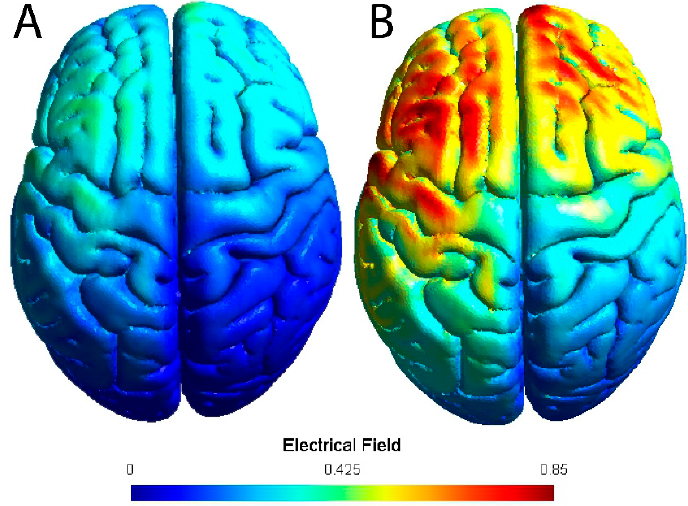
Figure 1. Model of the electrical field of the transcranial direct current stimulation montage used. The anode was placed over C3 and the cathode over the contralateral supraorbital area. ( A ) Electrical field using a standard 2 mA intensity. ( B ) Electrical field using a 4 mA intensity.